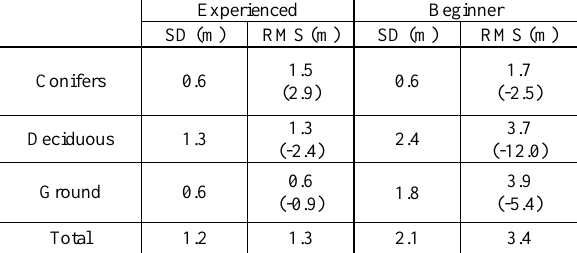
Table 1. Accuracy results of height